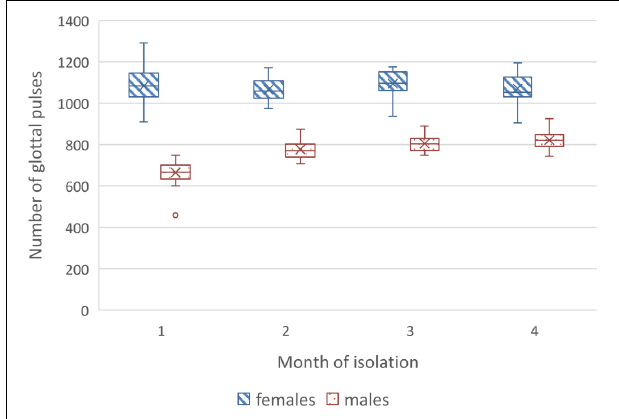
FIGURE 6 | Dynamics of vocal (glottal) pulses in female and male crew members